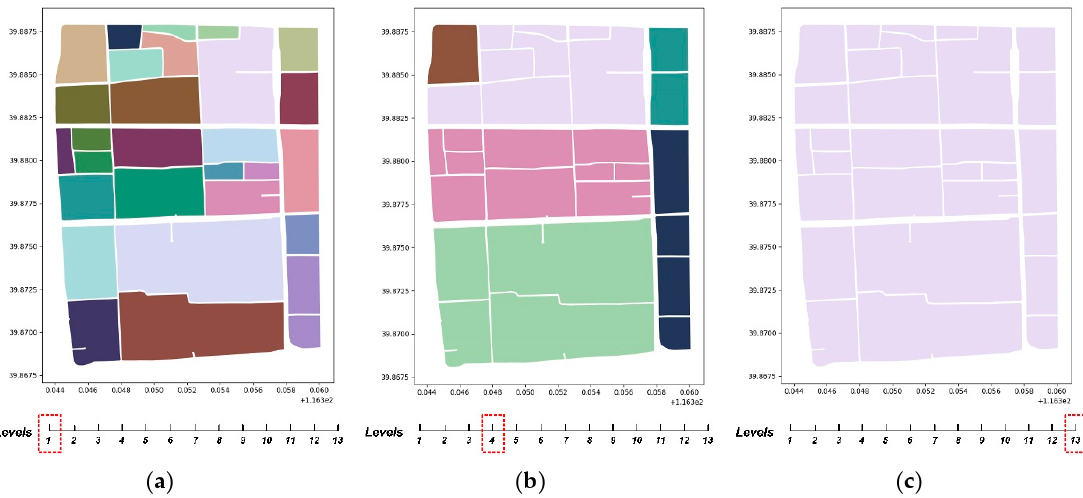
Figure 8. Illustration of step-by-step tuning within 13 levels: ( a ) parcel grouping at level 1; ( b ) parcel grouping at level 4; ( c ) parcel grouping at level 13.